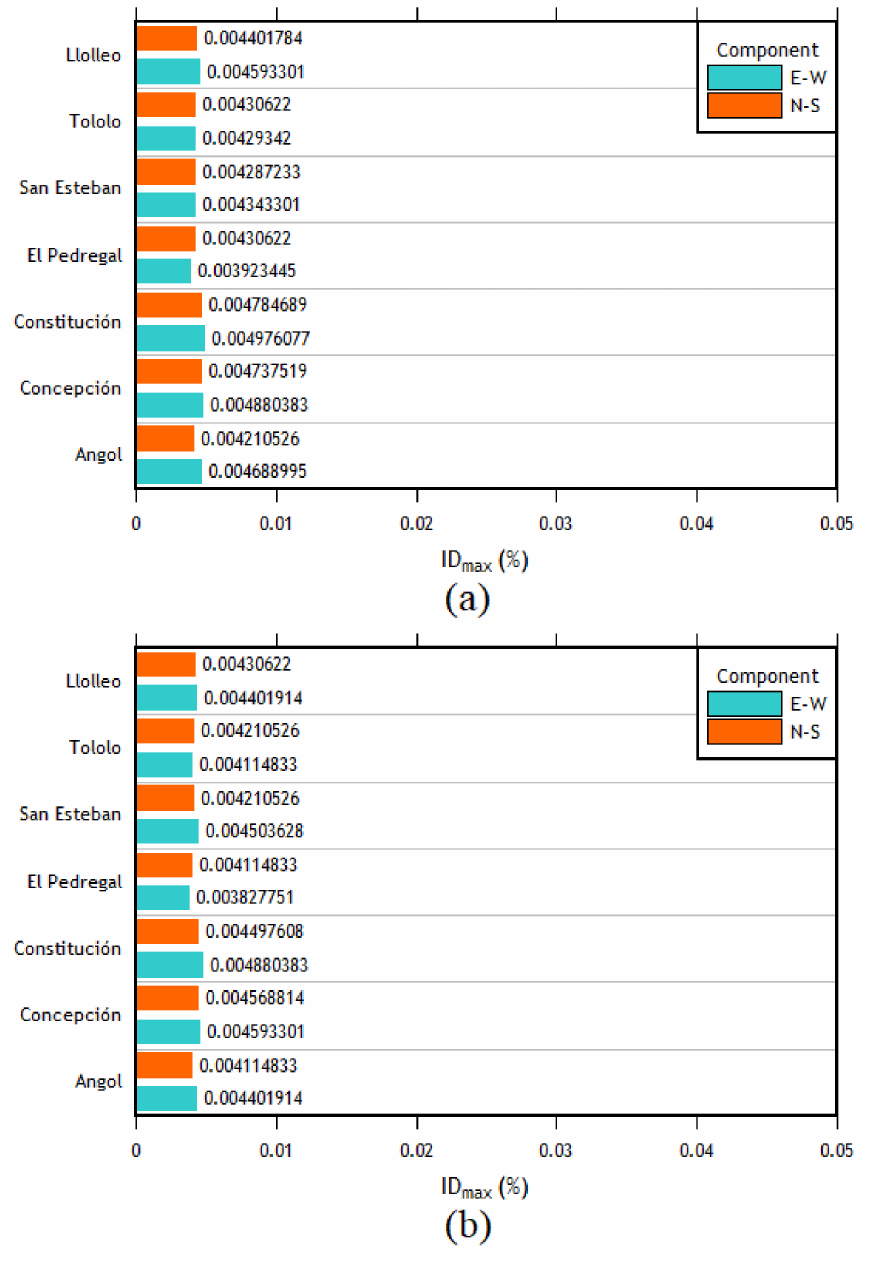
Figure 12. ( a ) Left center column interstory drifts of the outer frames, longitudinal direction. ( b ) Right center column interstory drifts of the outer frames, longitudinal